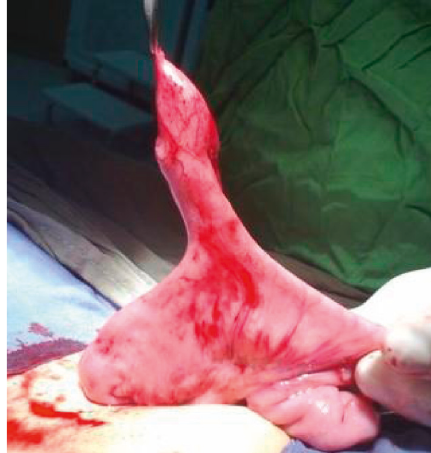
Figure 3: An intraoperative picture showing a Meckel’s diver- ticulum that caused bleeding per rectum and the histopathology showed the presence of an ectopic gastric